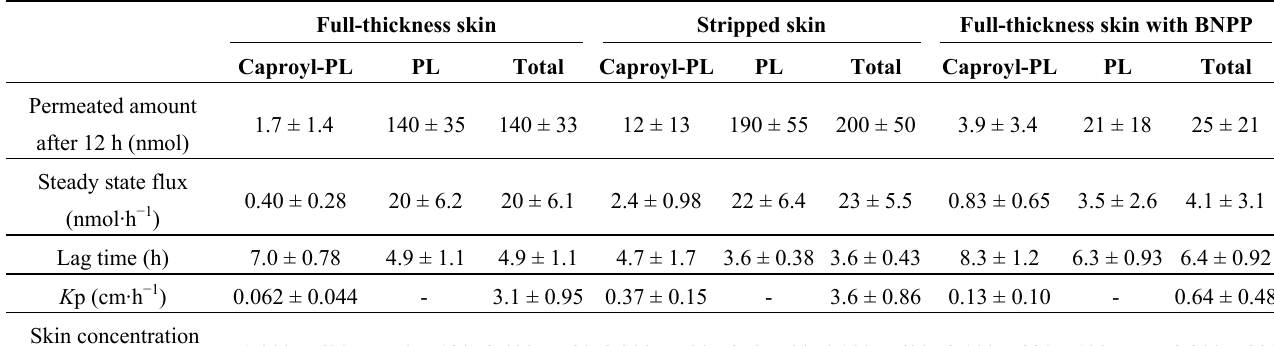
Table 2. Pharmacokinetic parameters for permeation of caproyl-PL across rat skin. Full-thickness skin Stripped